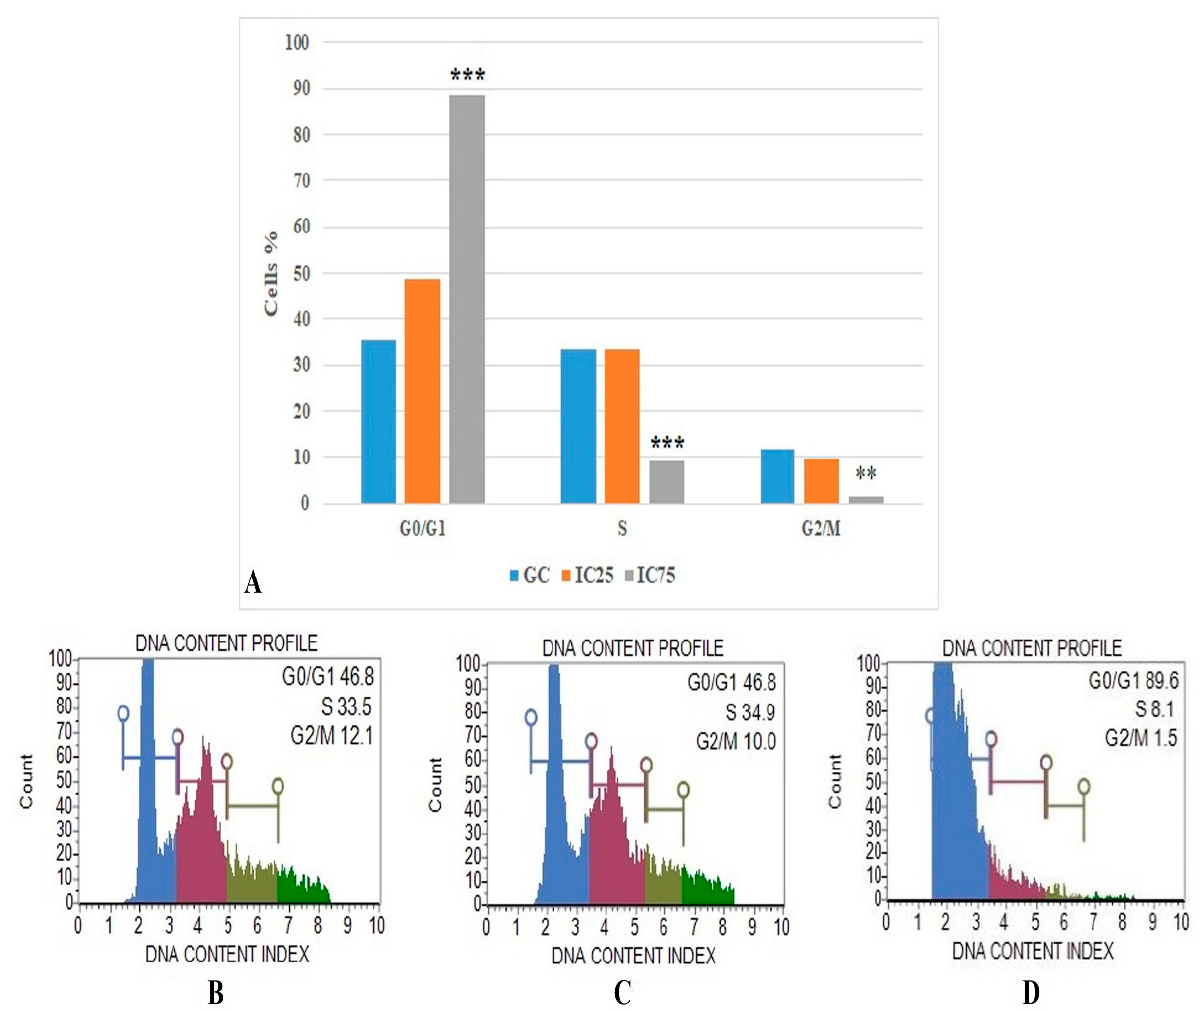
Figure 7. ( A ) Results of cell cycle arrested analysis. GC: growth control. Data represent the average value of three independent cell cycle arrested analyses. Error bars: the standard deviation of the mean. Asterisk: significantly different from the control (***: p < 0.001). ( B – D ): Sample plots to cell cycle arrested analysis from Muse Cell Analyzer. ( B ) Growth control; ( C ) IC25; ( D ) IC75.